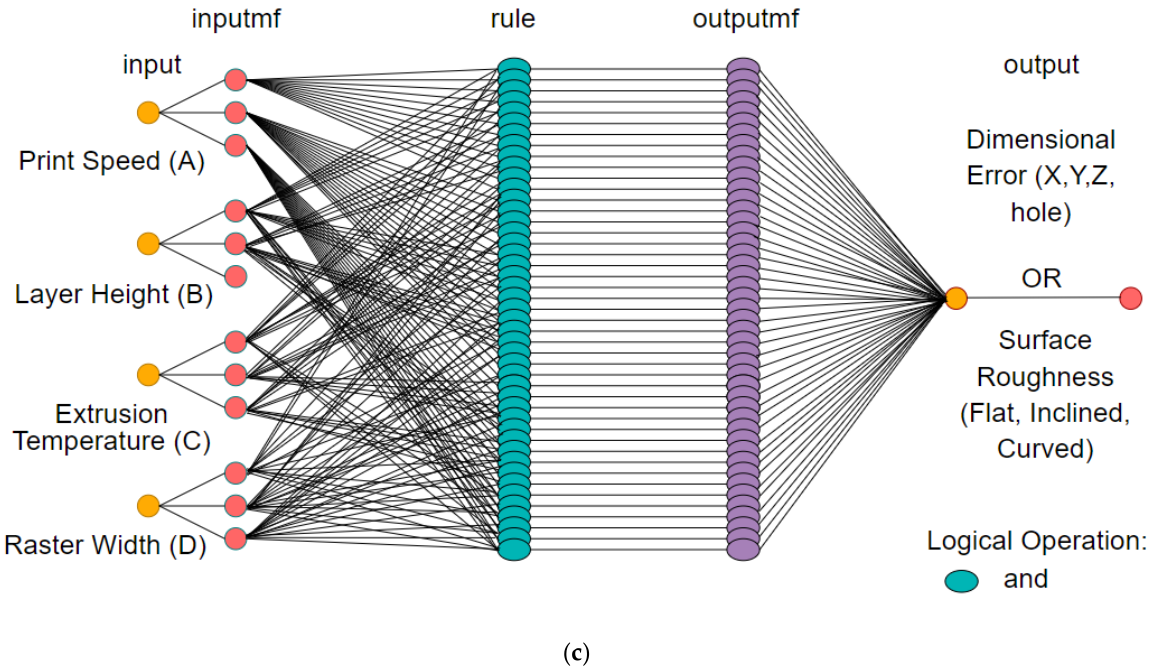
Figure 5. ( a ) ANFIS structure ( b ) ANFIS workflow ( c ) representative ANFIS architecture generated in MATLAB.